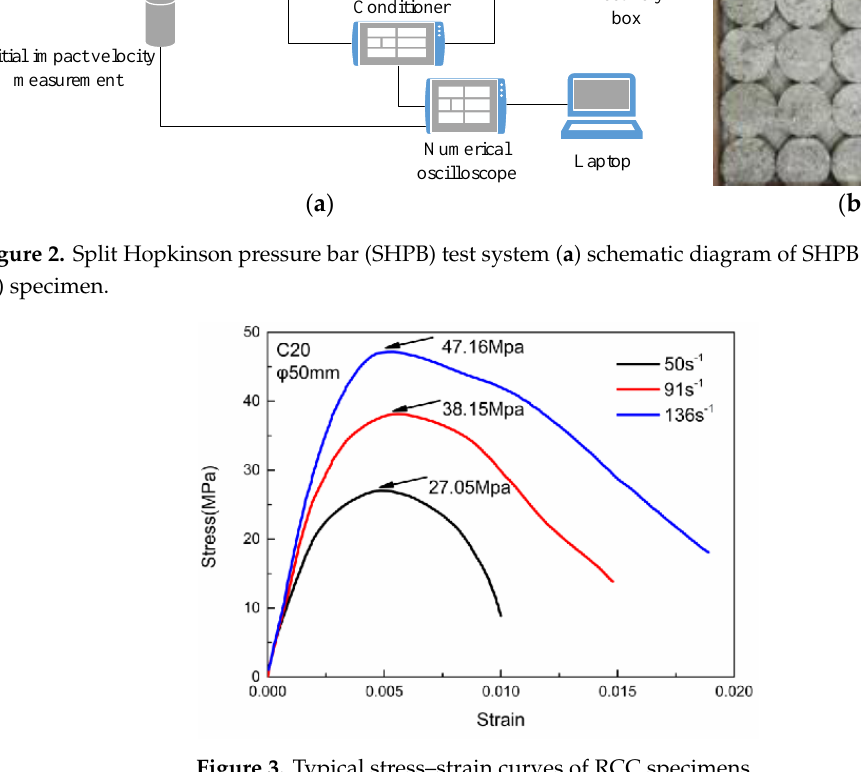
Figure 3. Typical stress–strain curves of RCC specimens.